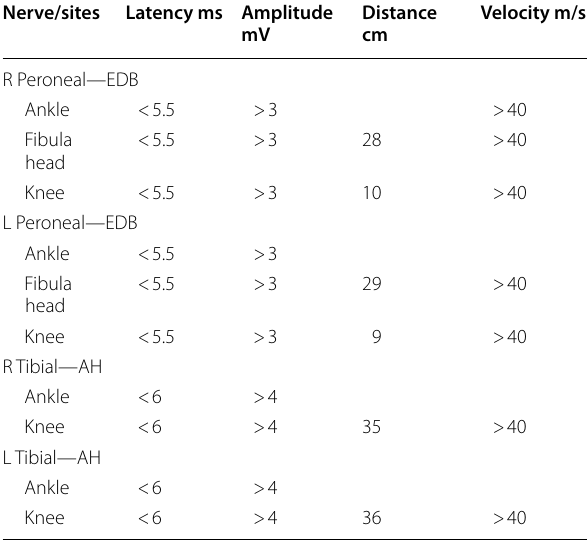
Table 1 Reference range for motor nerve conduction studies of lower